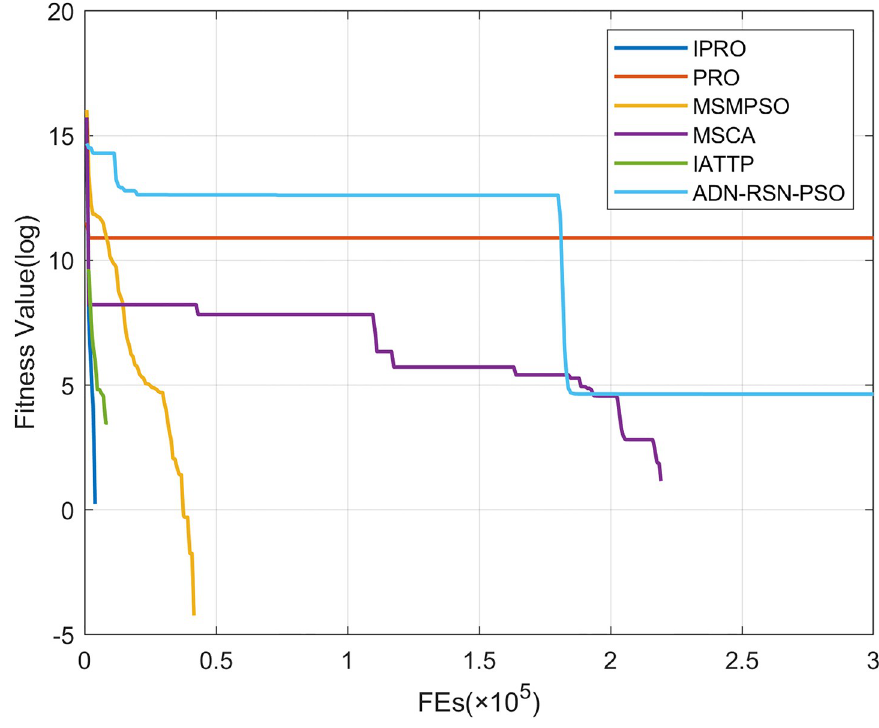
Fig 7. Convergence curves on F7.